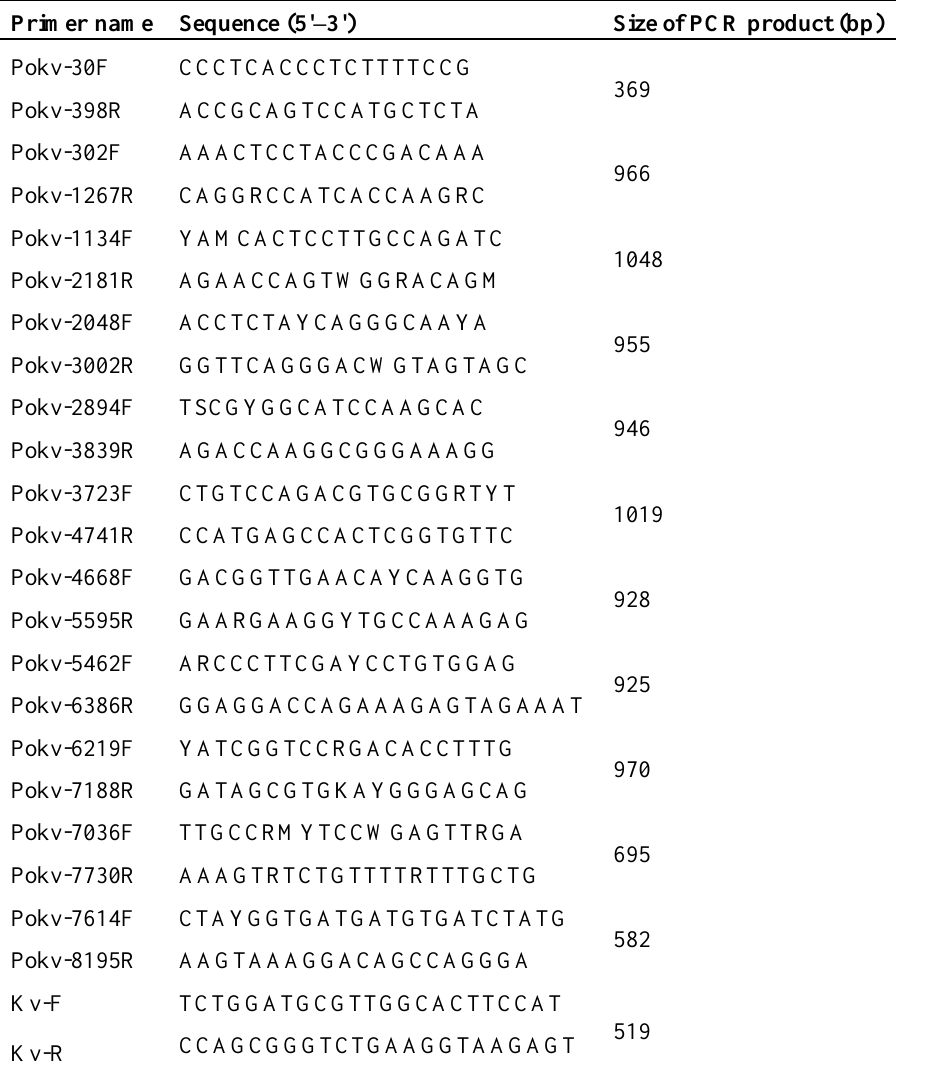
Table 3. Primers designed from contigs to acquire the porcine kobuvirus